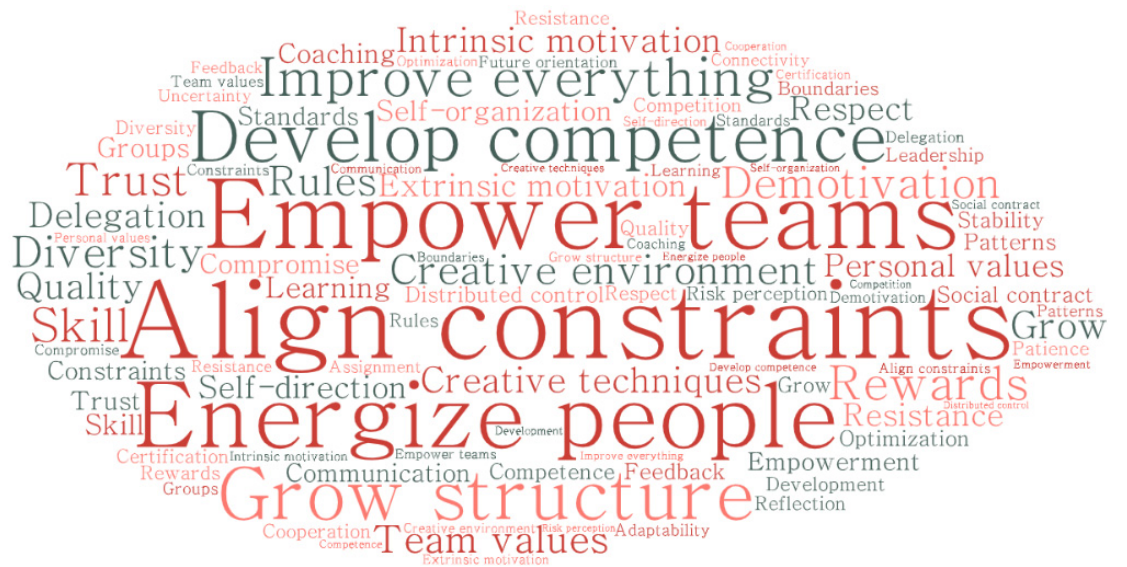
Figure 1. Cloud of themes associated with Management 3.0.